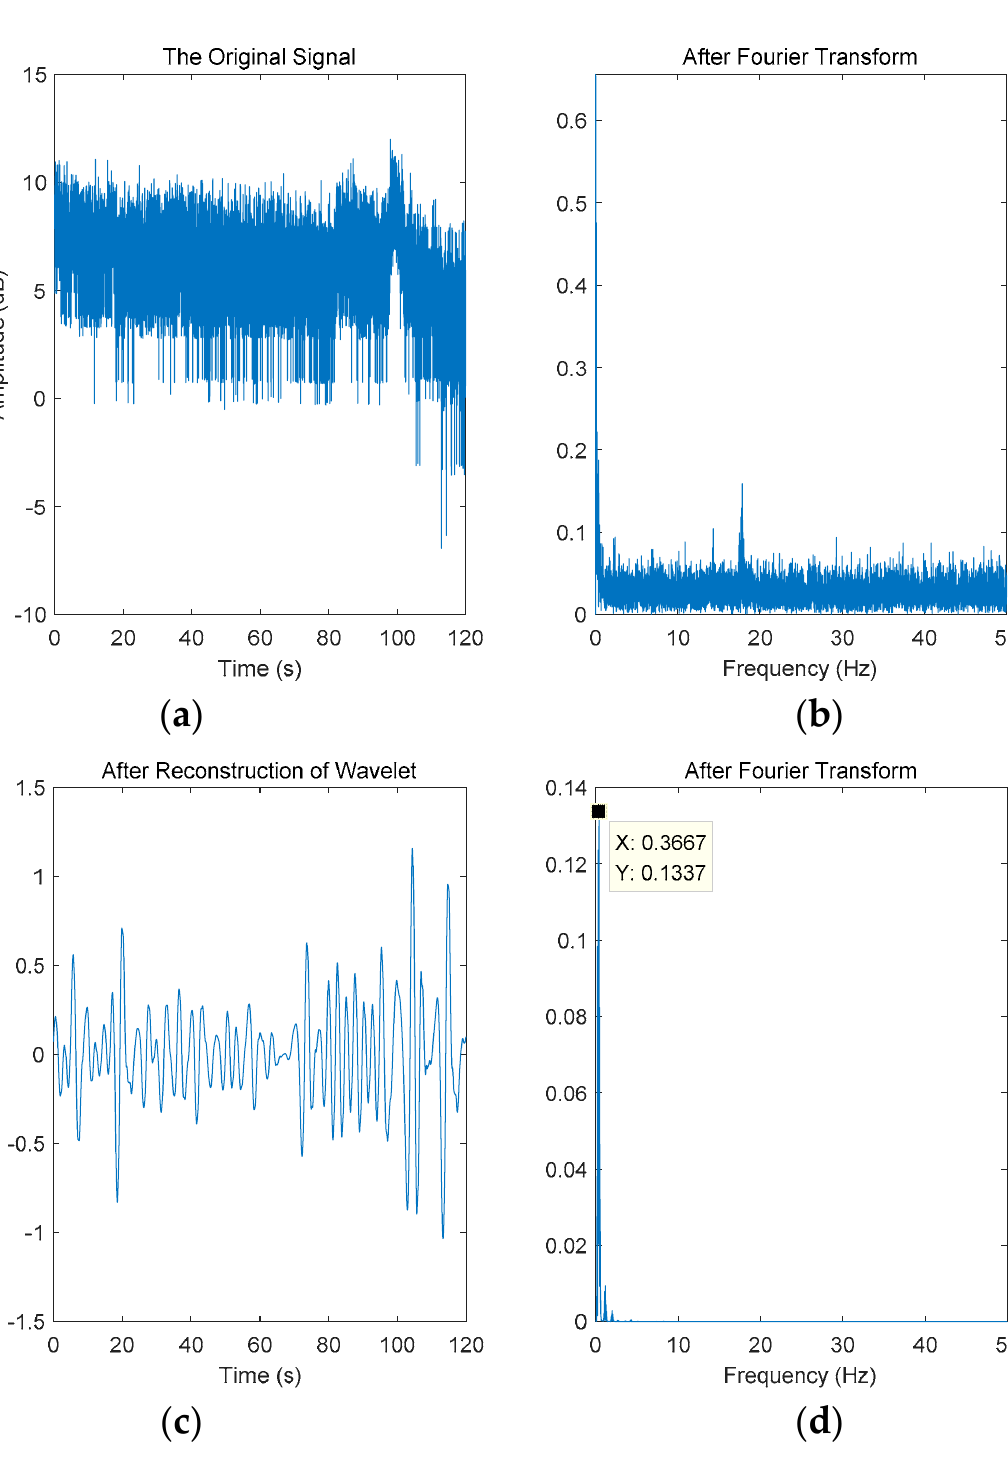
Figure 6. The data of the 16th subcarrier of the third antenna for a person laying down. ( a ) Time domain signal of the subcarrier. ( b ) Fourier transform of subcarrier. ( c ) Time domain signal after subcarrier wavelet reconstruction. ( d ) Fourier transform of wavelet reconstruction signal. This relative error was still high, and an improved algorithm was needed to reduce the relative error. This method needed to have good robustness and good performance for different